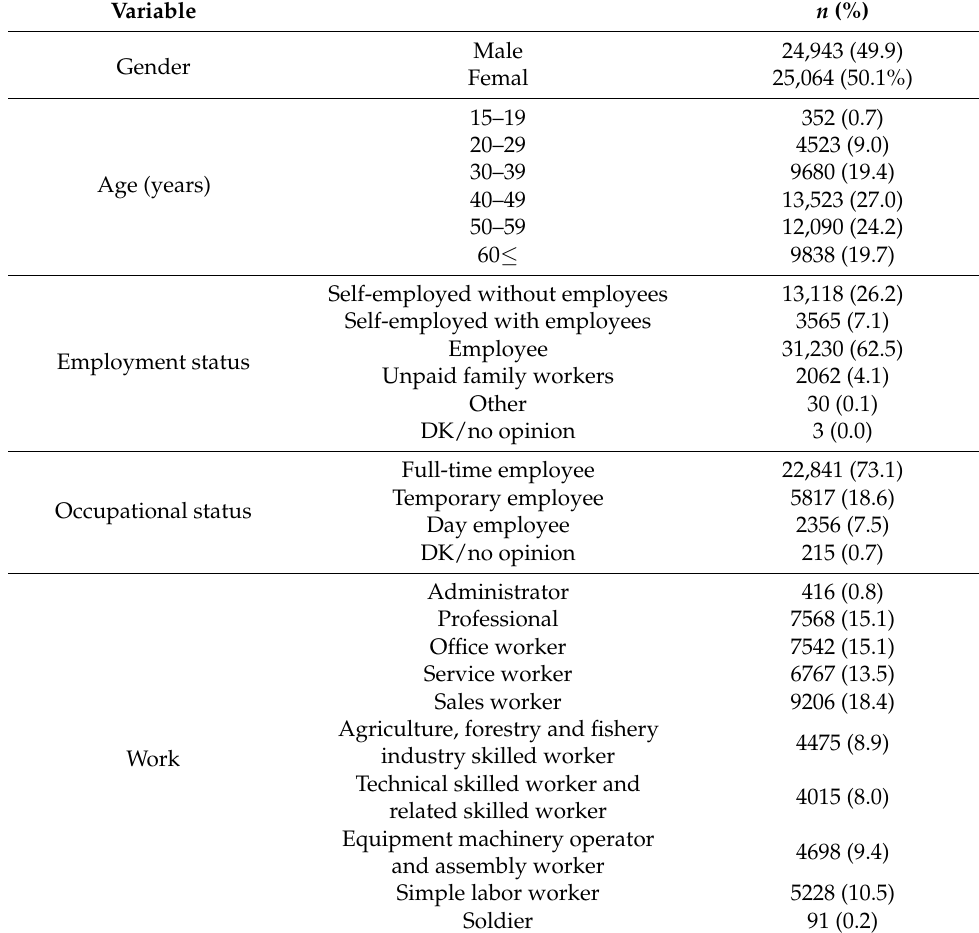
Table 1. General Characteristics of the Study Population ( n =